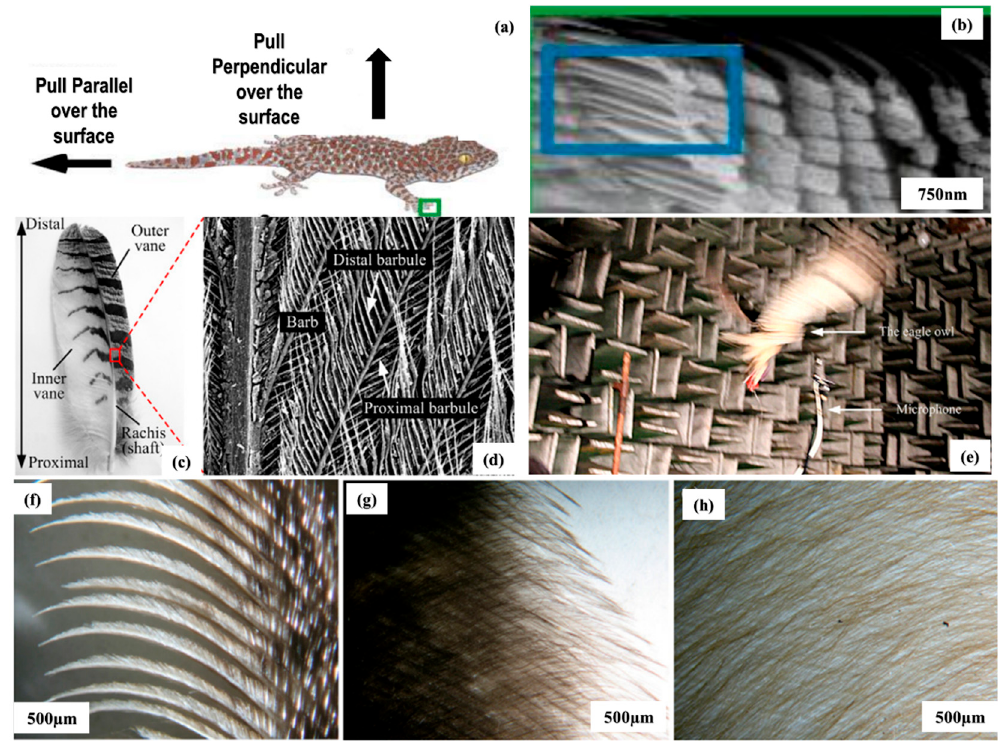
Figure 5. ( a , b ) Pictorial representation of Gecko along with SEM image of setae from the toe, ( c – e ) feather over the wings of owl in a different direction showcases the measurement of noise during flight, ( f ) feather at the leading edge, ( g ) trailing edge, and ( h ) surface of vane [128,173]. Copyright permission from Elsevier, 2012 and 2016.